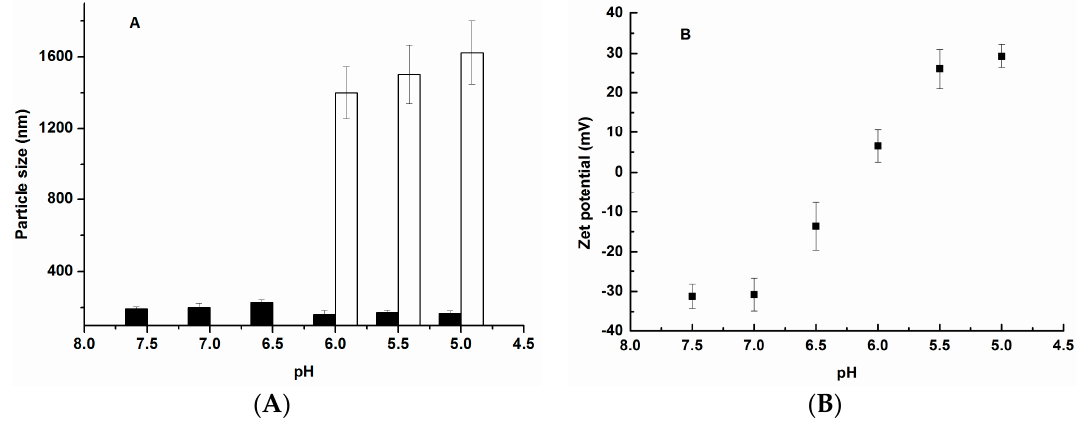
Figure 3. Particle size ( A ) and zeta potential ( B ) of DNA/PEI/PPSD (1:1:32) ternary complexes at various pHs. The solid bars could be the DNA/PEI complex and the open bars may be the aggregates of neutral PPSD in the ( A ).